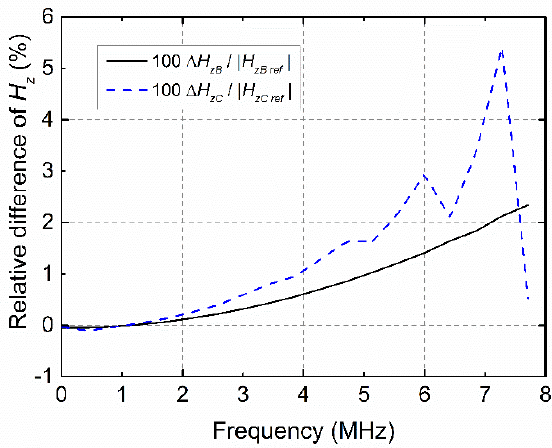
Figure 16. Relative difference in H z between the TLM results proposed in this work using a uniform mesh with principal axes oriented along the Cartesian axes, compared with results obtained using a non-uniform mesh with principal axes rotated by 120° with respect to the Cartesian ones. The difference was normalized to the solution obtained for principal axes oriented along the Cartesian axes.